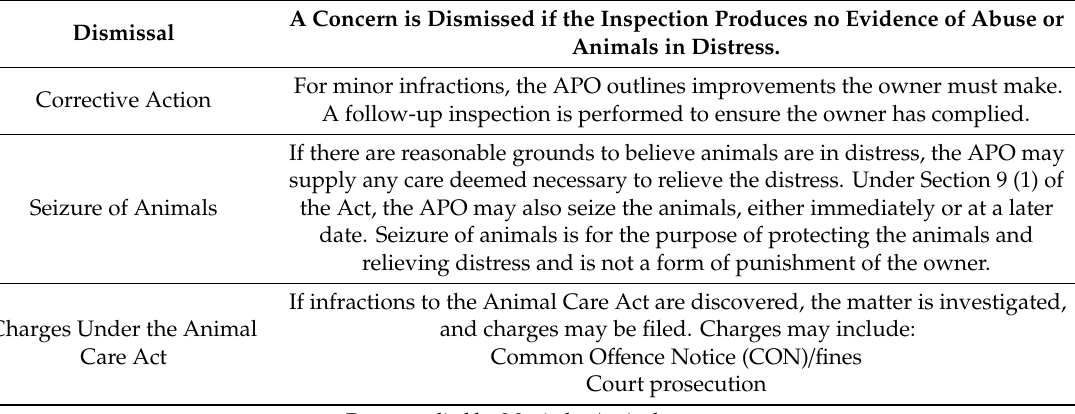
Table 2. Results of Animal Cruelty Inspections as Outlined by the CVO.